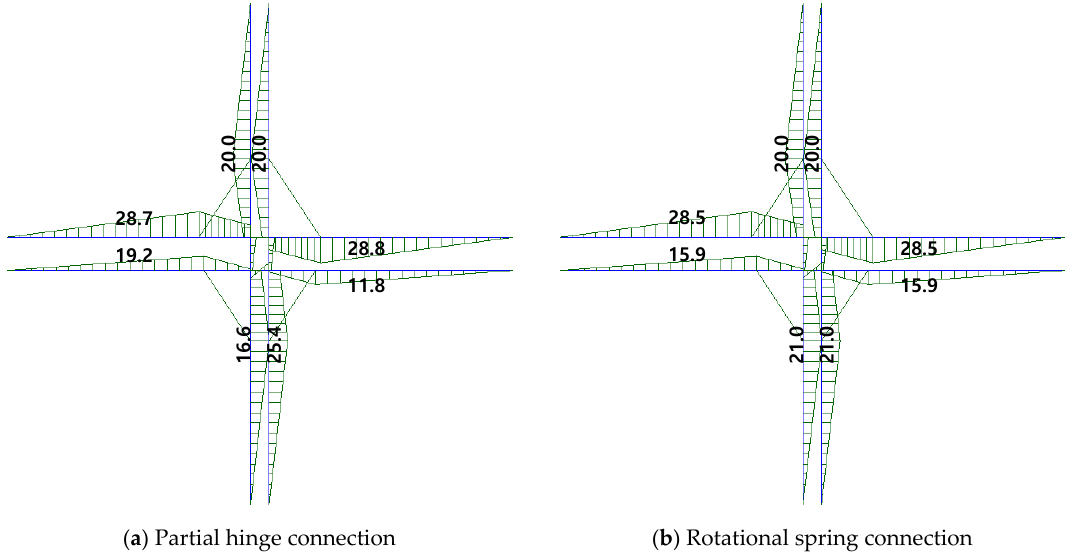
Figure 19. Linear elastic moment distribution of IC_OB_B specimen at P = 40 kN. (unit: kN·m).